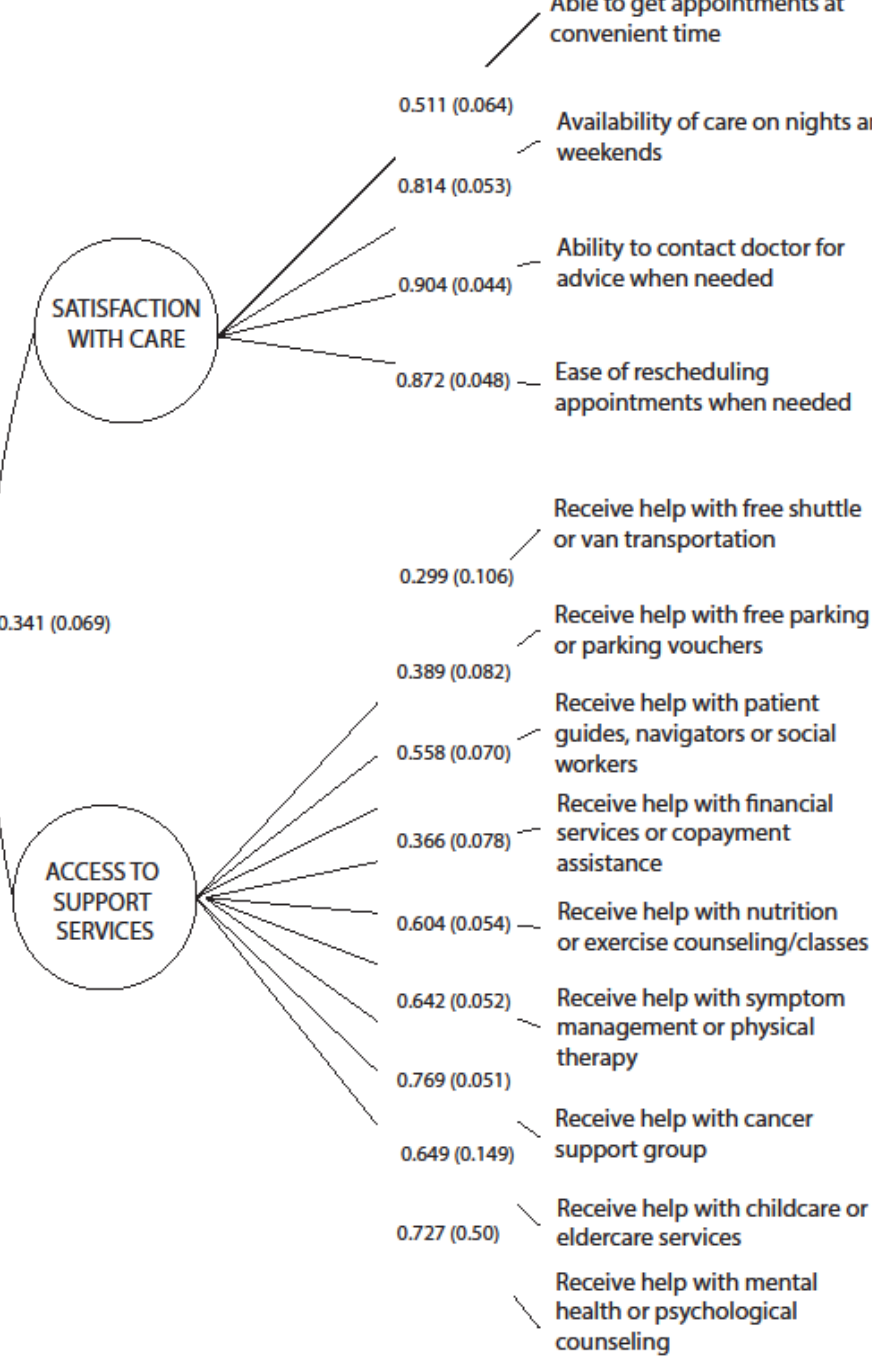
Figure 2. A Two-Factor Model of Accommodation Dimension.